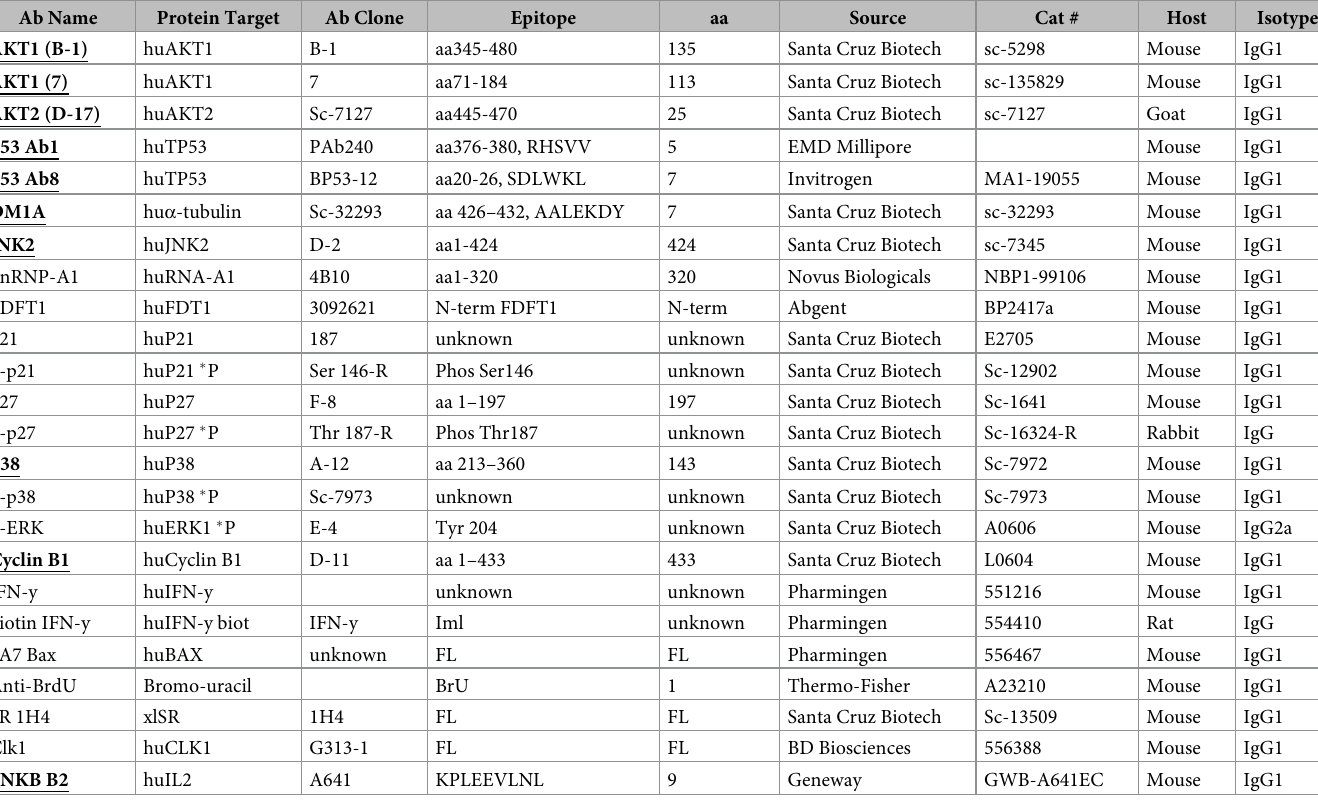
Table 2. Table of commercially-sourced antibodies used. Ab Name is the title of the antibody as sold by the manufacturer. Protein target is the gene name of the protein that served as the antigen. Ab Clone is the nomenclature the manufacturer uses to identify the hybridoma cell lineage. Epitope is the target of the antibody, generally the position in the Protein Target (when known) that contains the exact epitope. Generally, a short Epitope implies a linear peptide was used as the immunogen. aa is the num- ber of amino acids included in the linear immunogen. Source is the manufacturer, along with the catalog number. Host is the mammalian animal host. Last, isotype is the class of antibody produced.